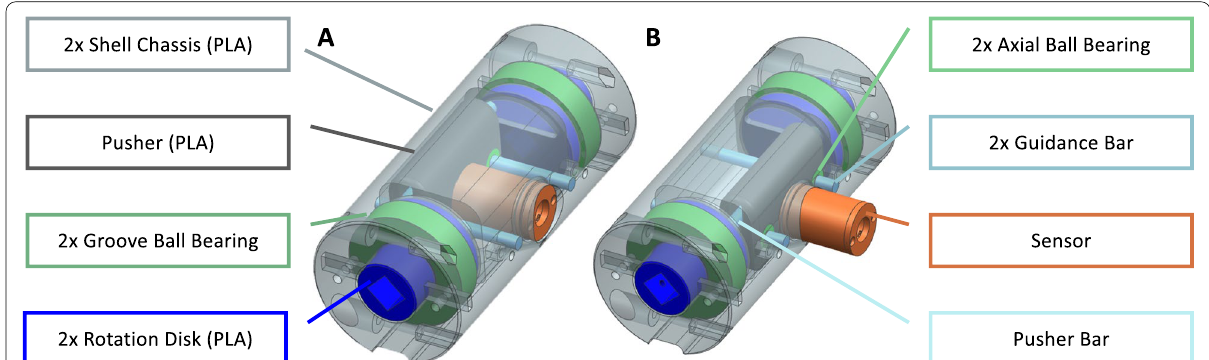
Fig. 4 Overview of the sensor push-out mechanism stored in the tube (without the protection tube): A Sensor inside the tube and B Sensor pushed out against the environment after turning the rotation disk by